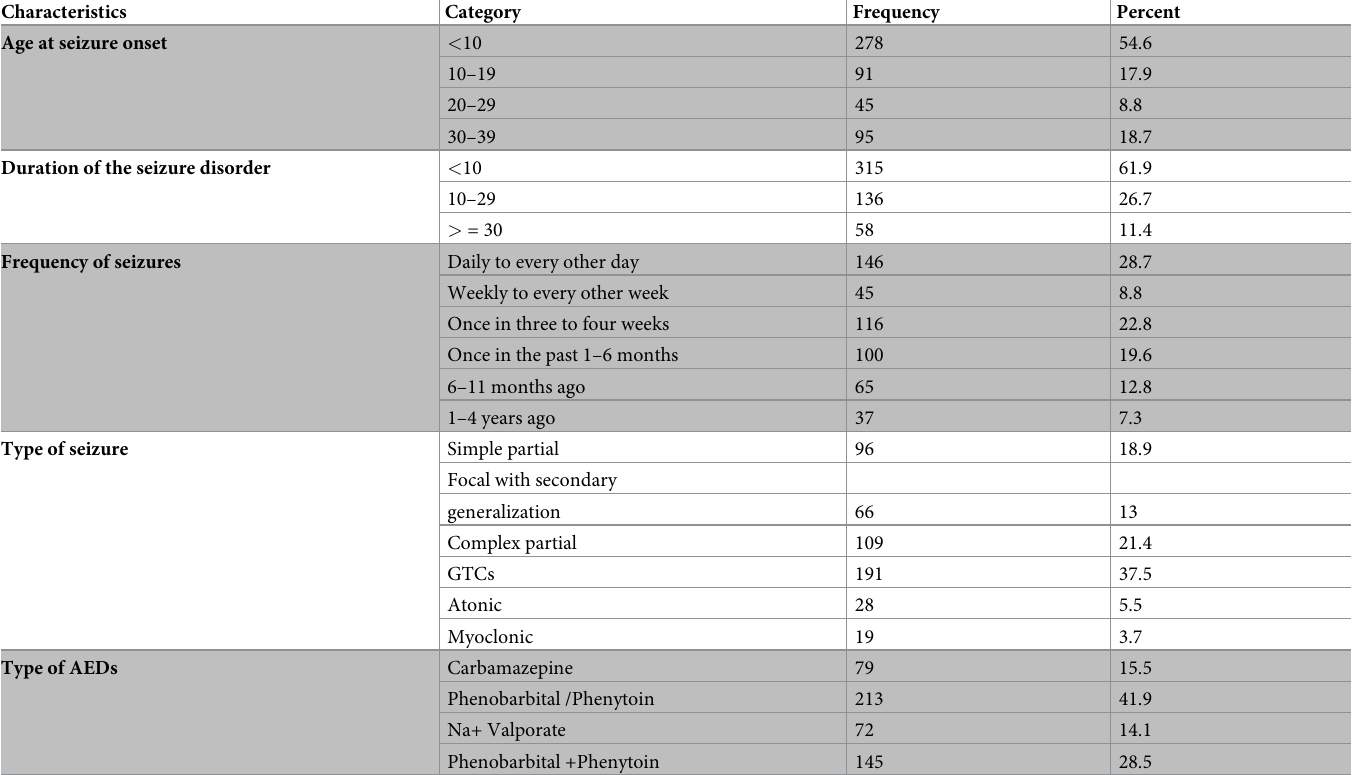
Table 2. Seizure and medication-related factors of cognitive impairment in patients with epilepsy attending outpatient department of south Gondar zone hospitals Amhara Ethiopia 2021(n = 509).